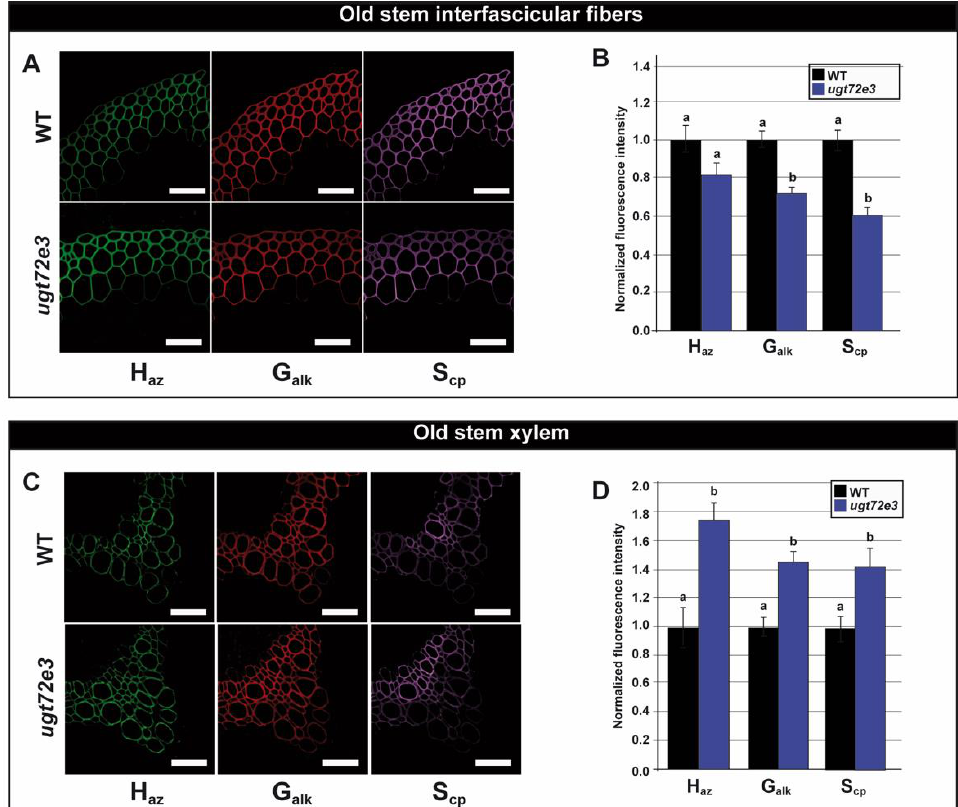
Figure 8. Monolignol incorporation capacity in the old part of the floral stem. The capacity of cell walls to incorporate monolignols into cell walls was evaluated by measuring the signal of fluorescent probes bound to monolignol chemical reporters metabolically incorporated into the lignin polymer. The tagged monolignol associated incorporation signal was localized in the interfascicular fibers and xylem cell walls ( A , C ). H az tagged lignin reporter unit signal appears in green, G alk in red and S cp in purple. Scale bar = 50 µm. The associated incorporation signal was quantified in ugt72e3 and compared to the WT ( B , D ). Means (± SD) with the same lowercase letters are not significantly different according to Student t-test ( p -value < 0.01, n = 3).